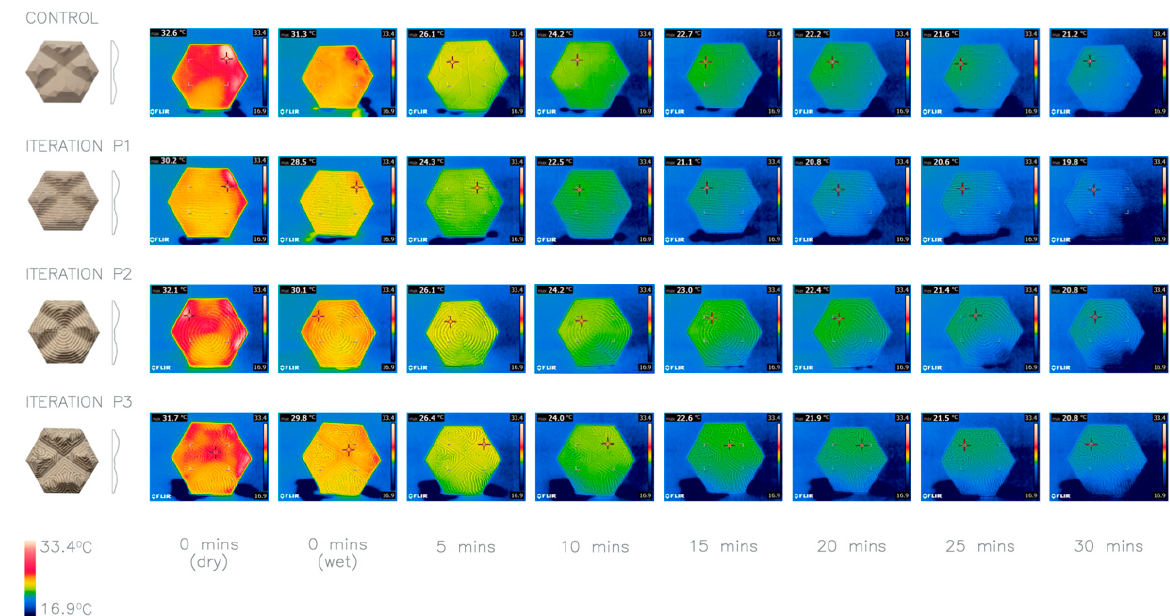
Figure 13. Thermal imaging of investigation 9: pattern introduction onto a textured panel. Iterations P1–3 compared with a control panel. Average heat loss after 30 min: Control 14.16 °C, P1 13 °C, P2 13.43 °C, P3 12.86 °C.